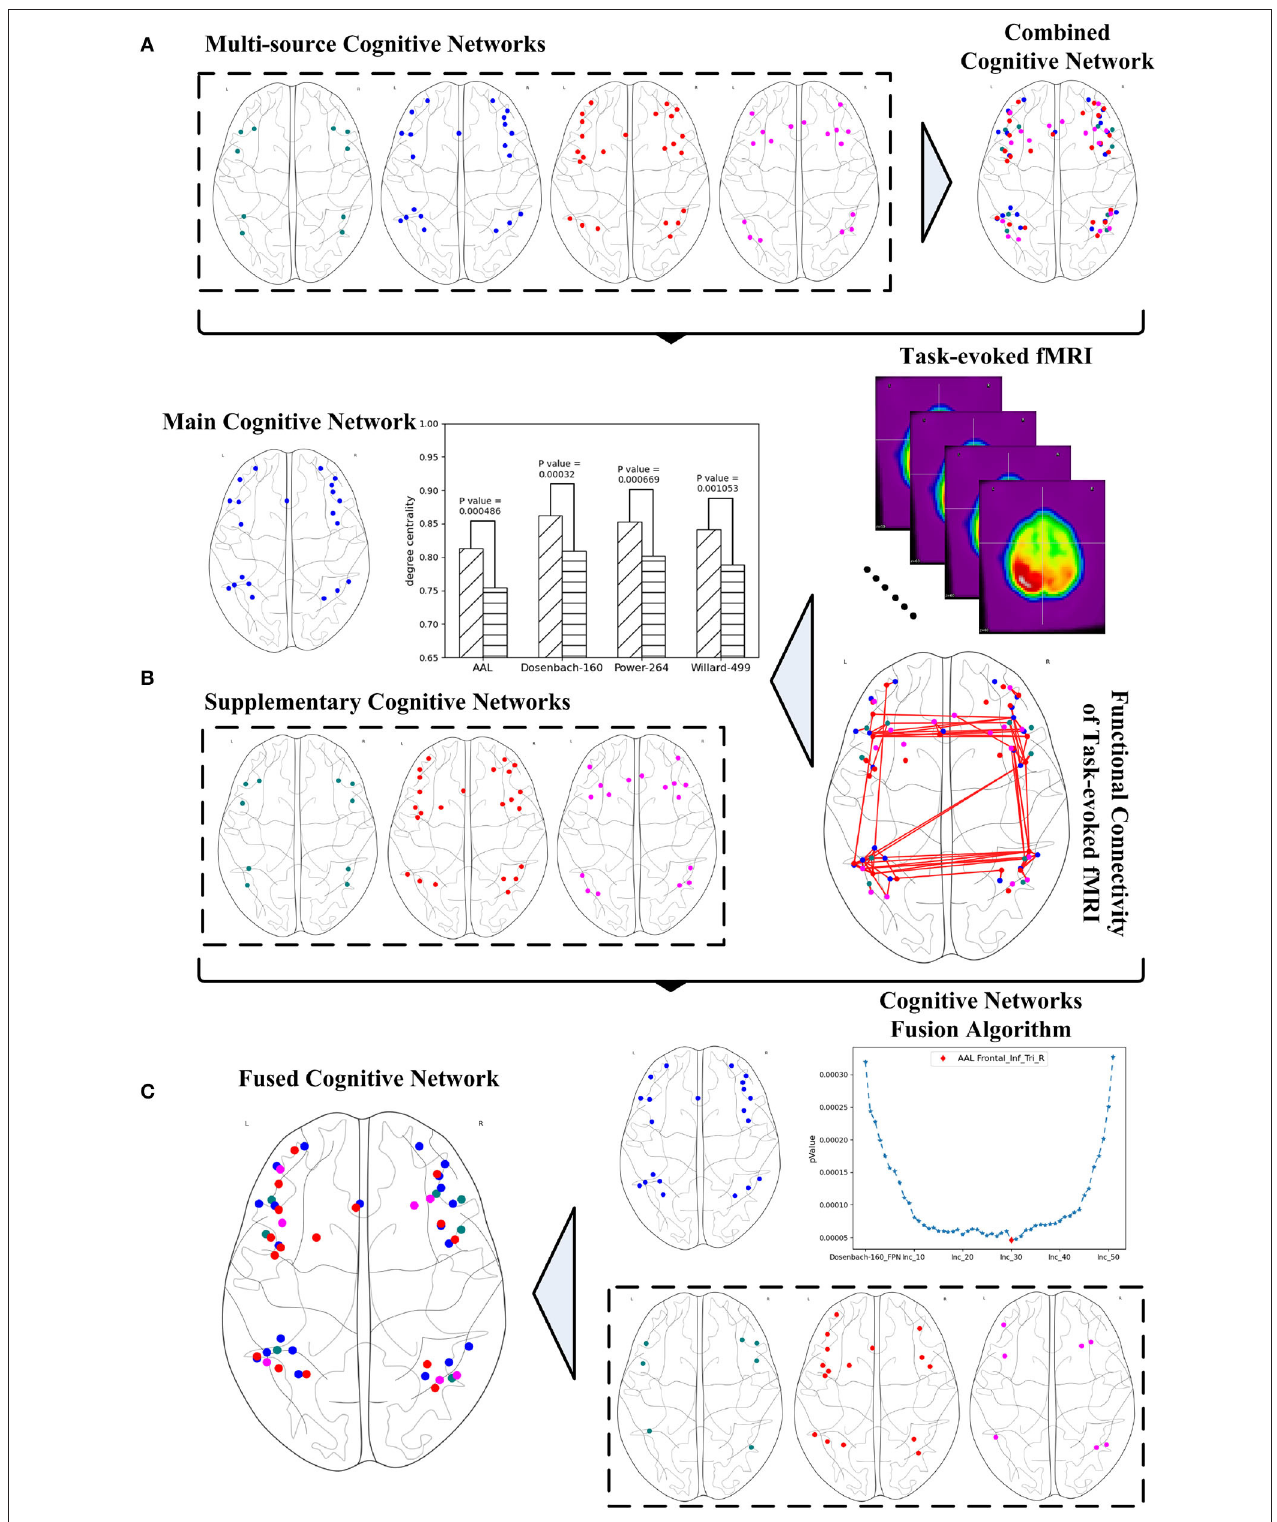
FIGURE 1 | Systematic fusion of multi-source cognitive networks, (A) combined cognitive network synthesized from multiple brain atlases, (B) main and supplementary cognitive networks obtained from graph analysis, (C) fused cognitive network computed from cognitive networks fusion algorithm.